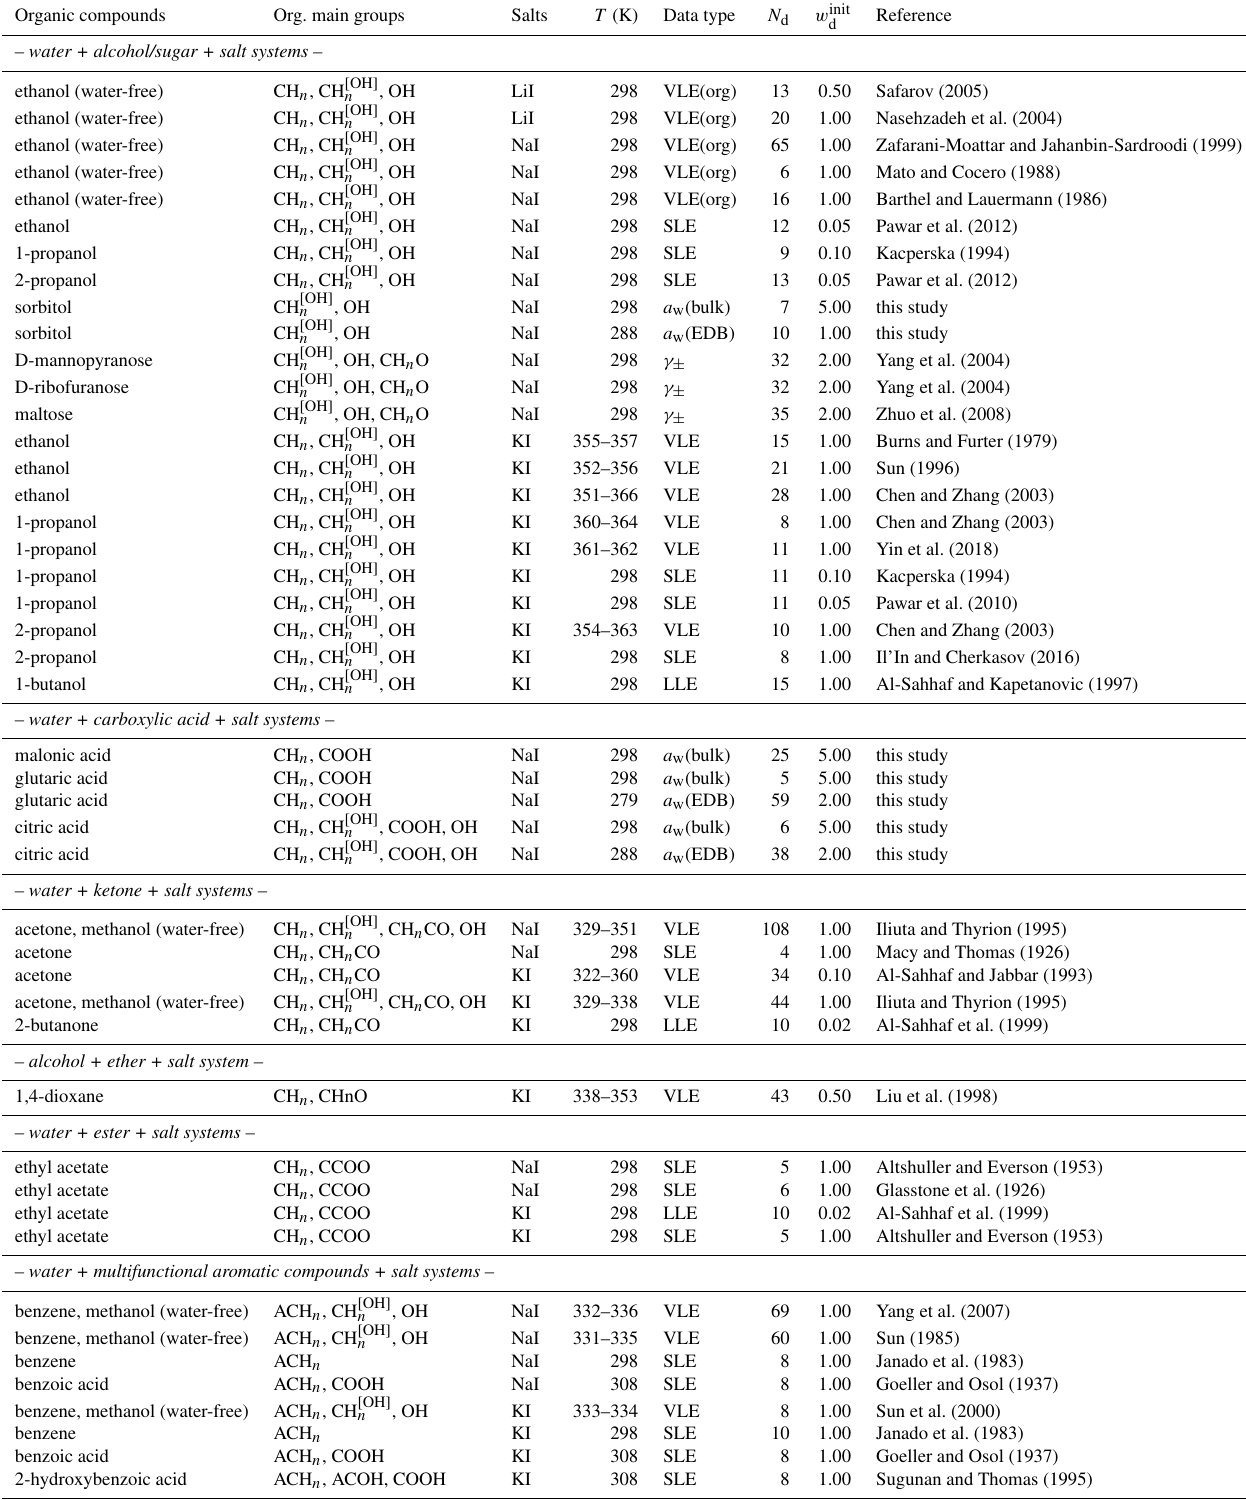
Table 3. Data summary of iodide salts mixed with organic compounds and thereby various organic main groups in aqueous solutions (unless specified